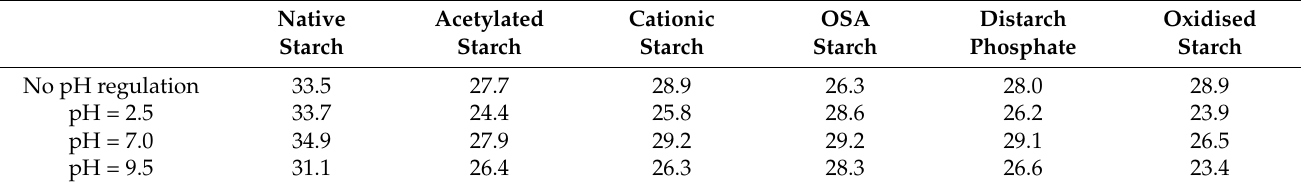
Table 4. Mean correlation time values τ c [10 − 8 s] for the analysed starch samples.